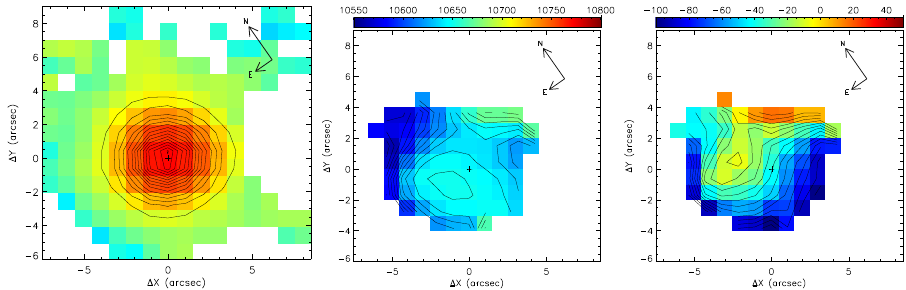
Fig. 4. MPFS data of Mrk 291 for [O III]: intensity map (left), velocity (cid:12)eld (middle) and the residual velocity map (right).